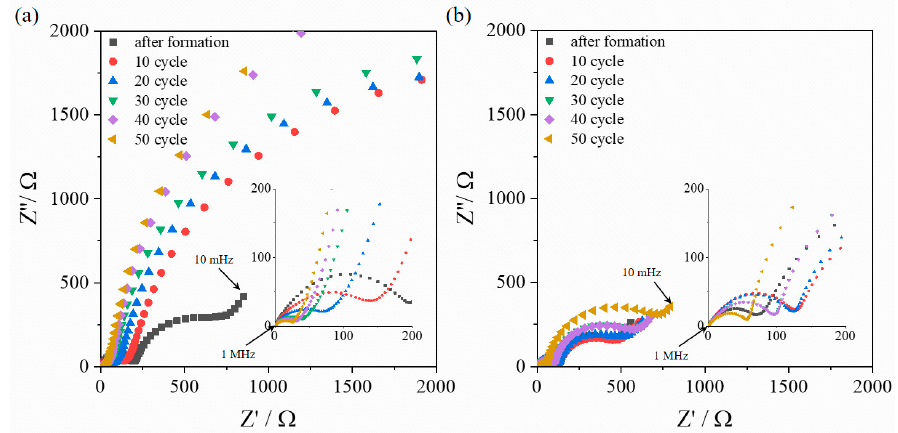
Figure 6. Nyquist plots of ( a ) Li[YBC] and ( b ) Li[YEBCG] with increasing cycle numbers. Through a series of EIS and CV measurements under various electrochemical